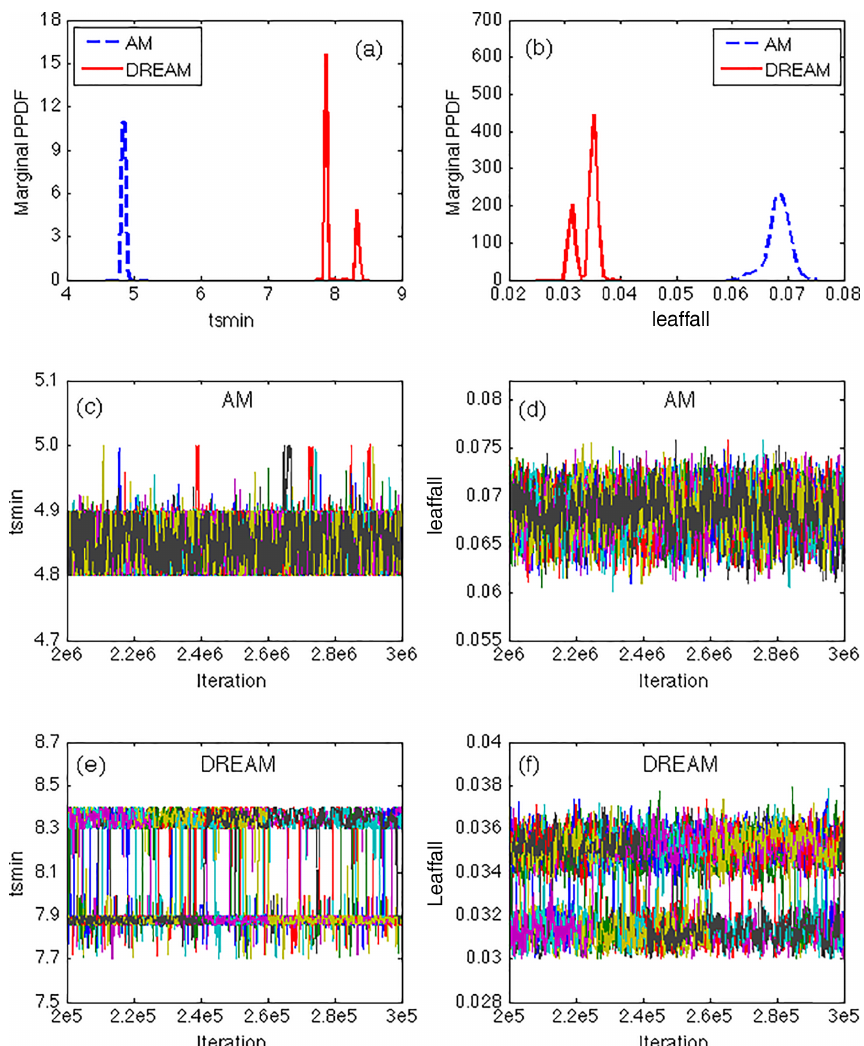
Figure 4. AM and DREAM results for parameters tsmin and leaffall in the DALEC model. The estimated marginal posterior distributions of (a) tsmin and (b) leaffall ; Trace plots of (c) sampled tsmin and (d) sampled leaffall with AM using 10 independent chains; and trace plots of (e) sampled tsmin and (f) sampled leaffall with DREAM using 10 interacting chains. The evolution of each chain is coded with a different